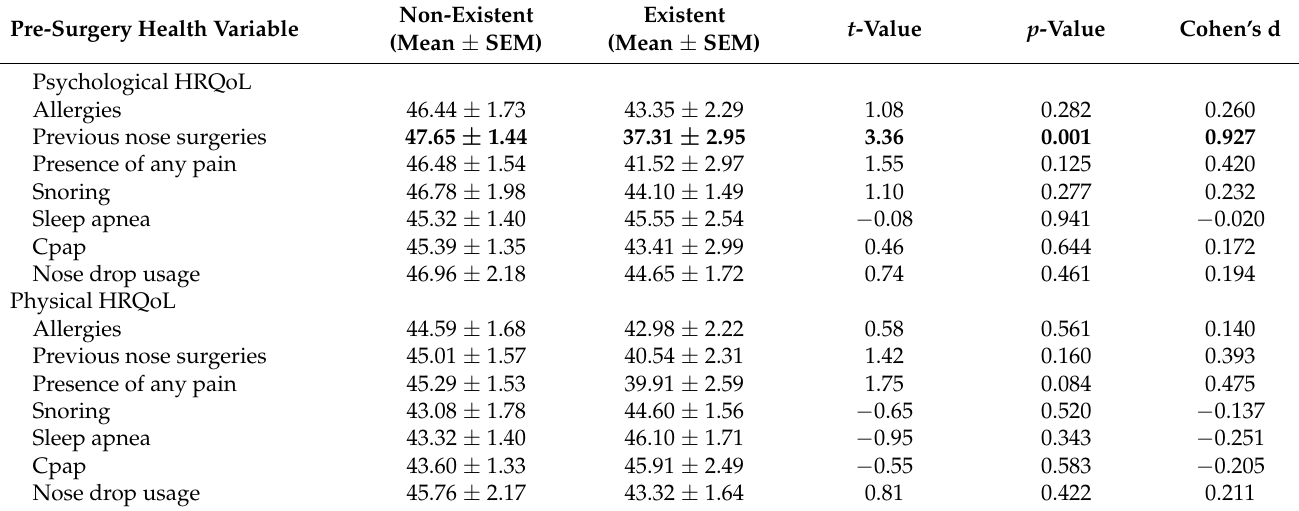
Table 2. SF-36: HRQoL based on pre-surgery health variables.